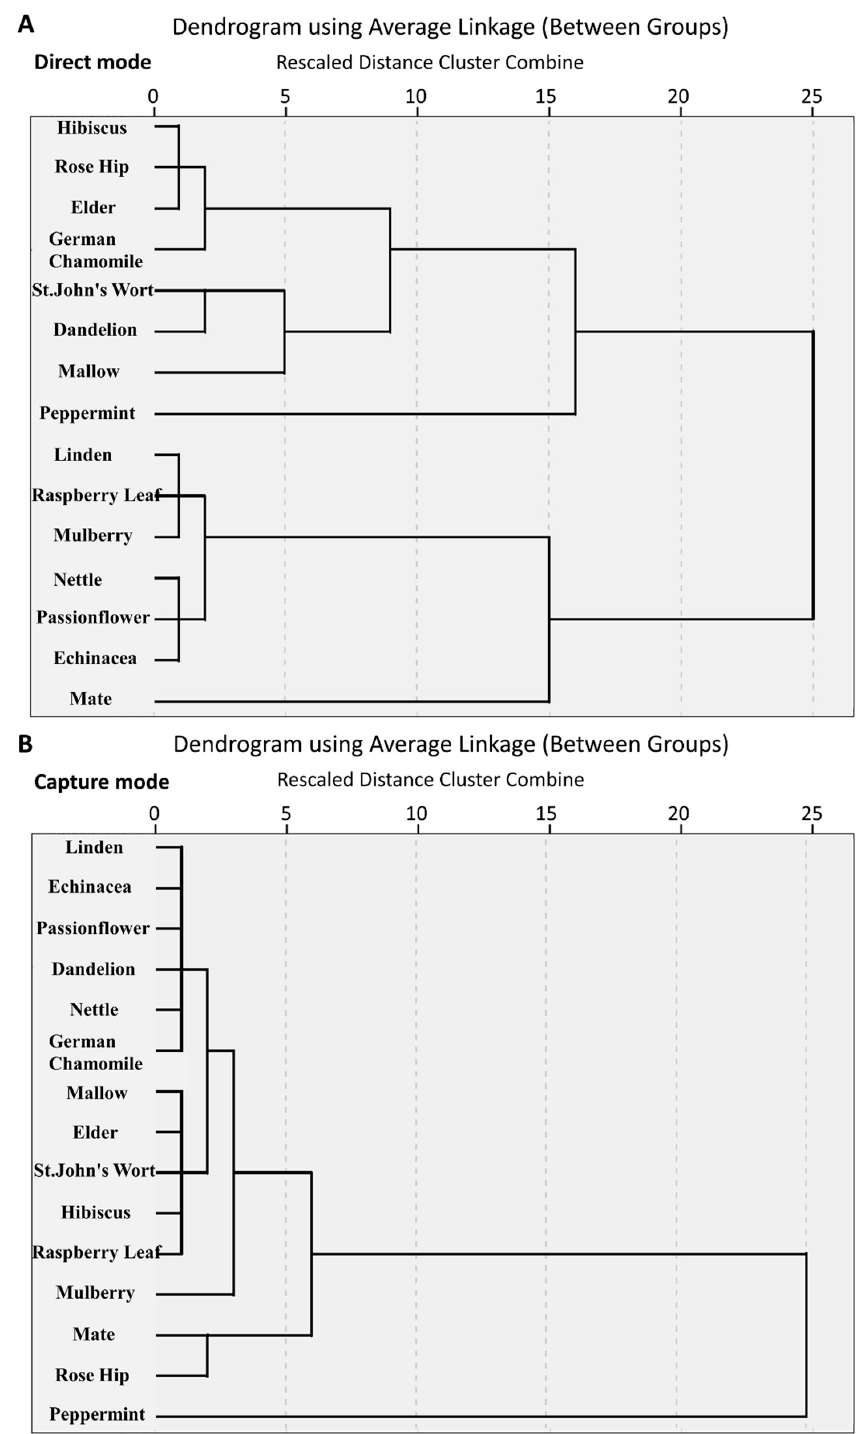
Figure 2. Dendrogram, calculated from the measured fragrance values of 15 herbs. Hierarchical cluster classification by SPSS17 (IBM) was used for statistical analysis. ( A ) Measurement in Direct mode, ( B ) Measurement in Capture mode. FF-2A allows creating new virtual reference axis from the gas values measured at different concentrations of the standard fragrance samples, and by projecting the values